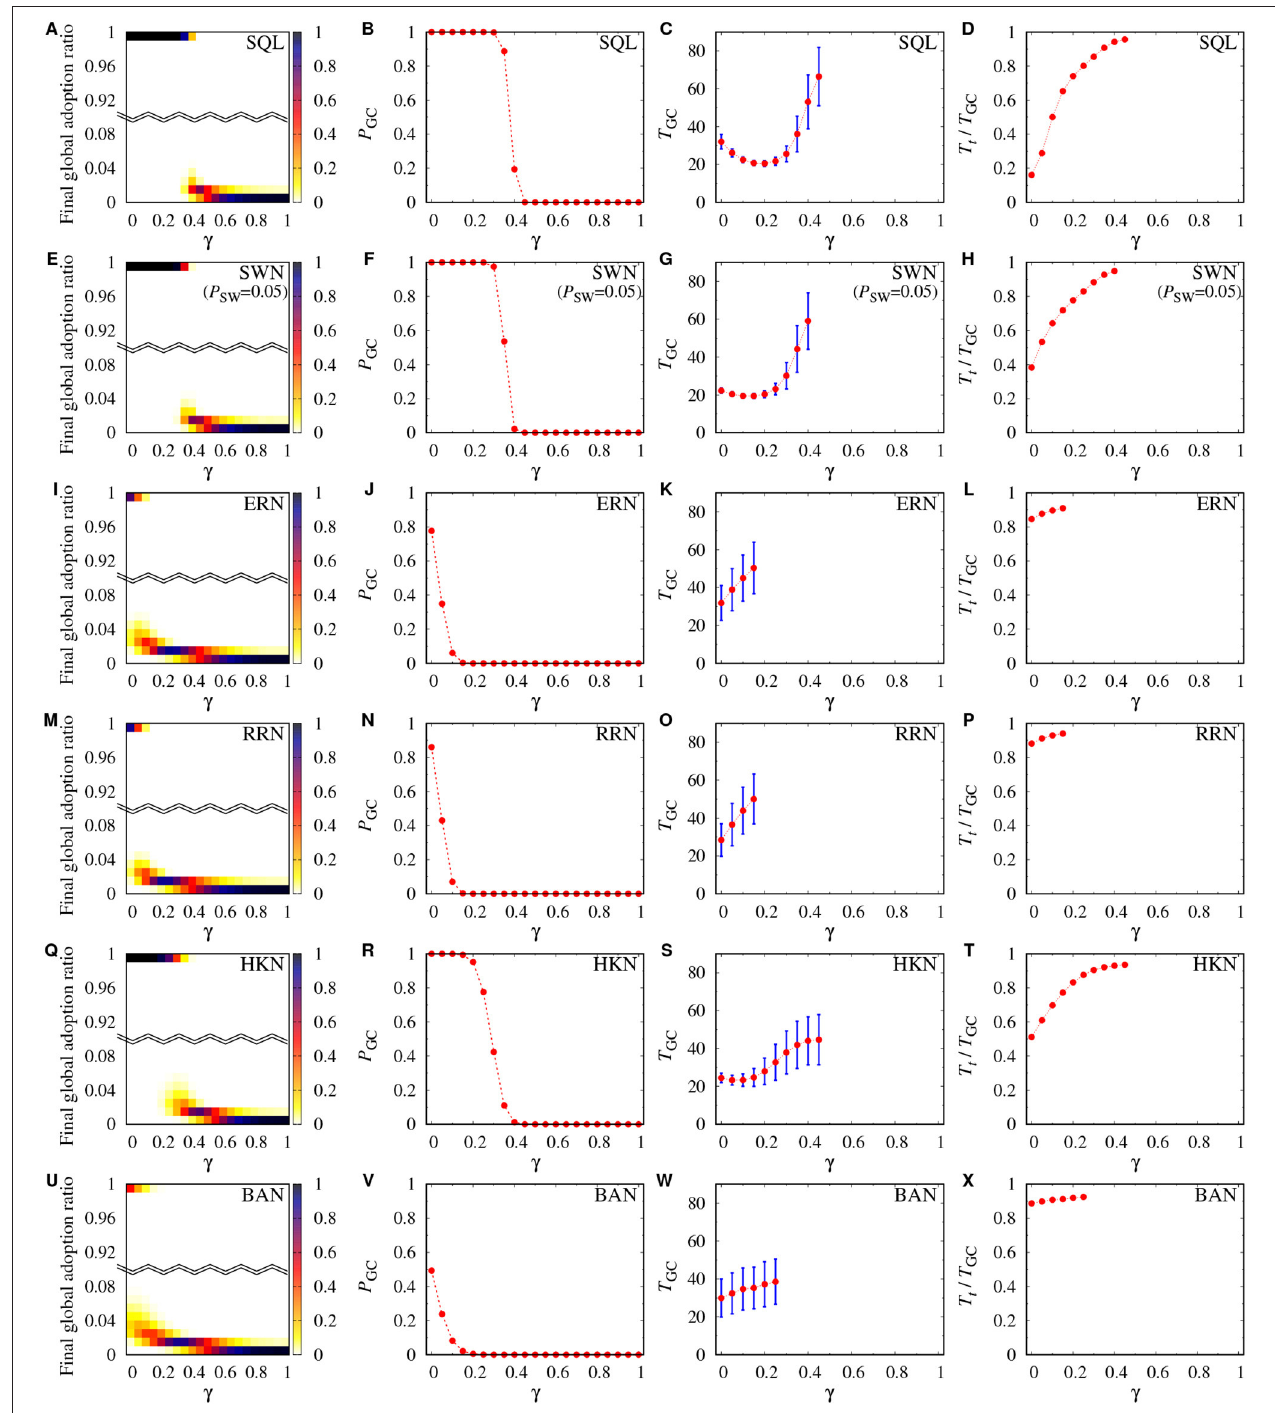
FIGURE 2 | The final global adoption ratio, the probability of global cascades ( P GC ), time to global cascades ( T GC ), and the ratio of time to tipping points ( T t ) to time to global cascades ( T GC ) as a function of γ for the six classes of networks: SQL (A–D) , SWN (E–H) , ERN (I–L) , RRN (M–P) , HKN (Q–T) , and BAN (U–X) . Global adoption ratio is the number of agents who adopt the new option N a over the whole population N of the network. Note that a vertical bar for each symbol of T GC represents a standard deviation of data, not a statistical error. As for P GC , T GC , and T t / T GC , error bars for statistical errors are smaller than the symbol sizes.